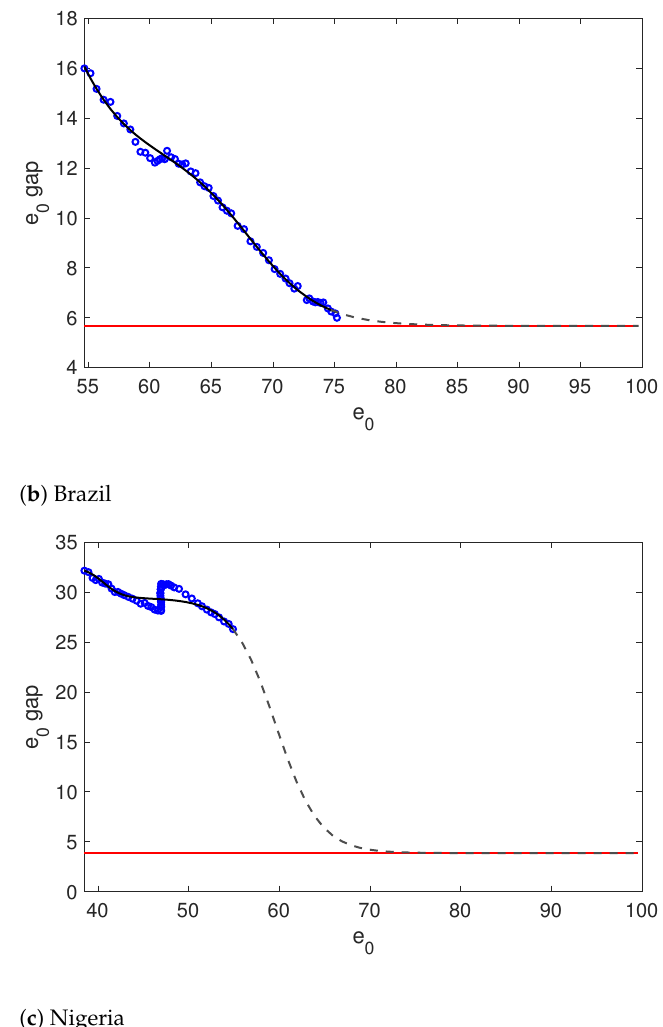
Figure 3. The observed, fitted, and predicted life expectancy gaps for China, Brazil, and Nigeria using their respective optimal logistic